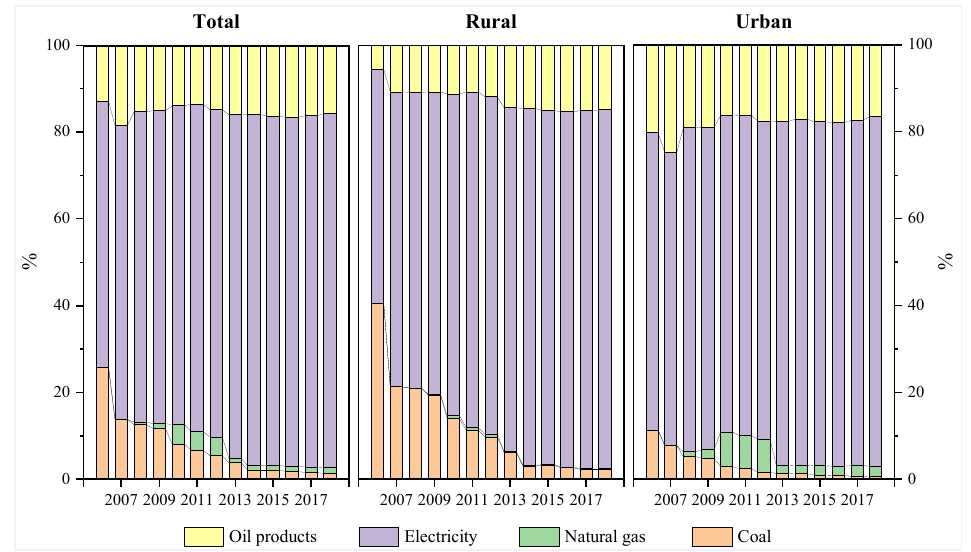
Figure 6. Energy structure of direct CO 2 emissions from household consumption in Fujian province.